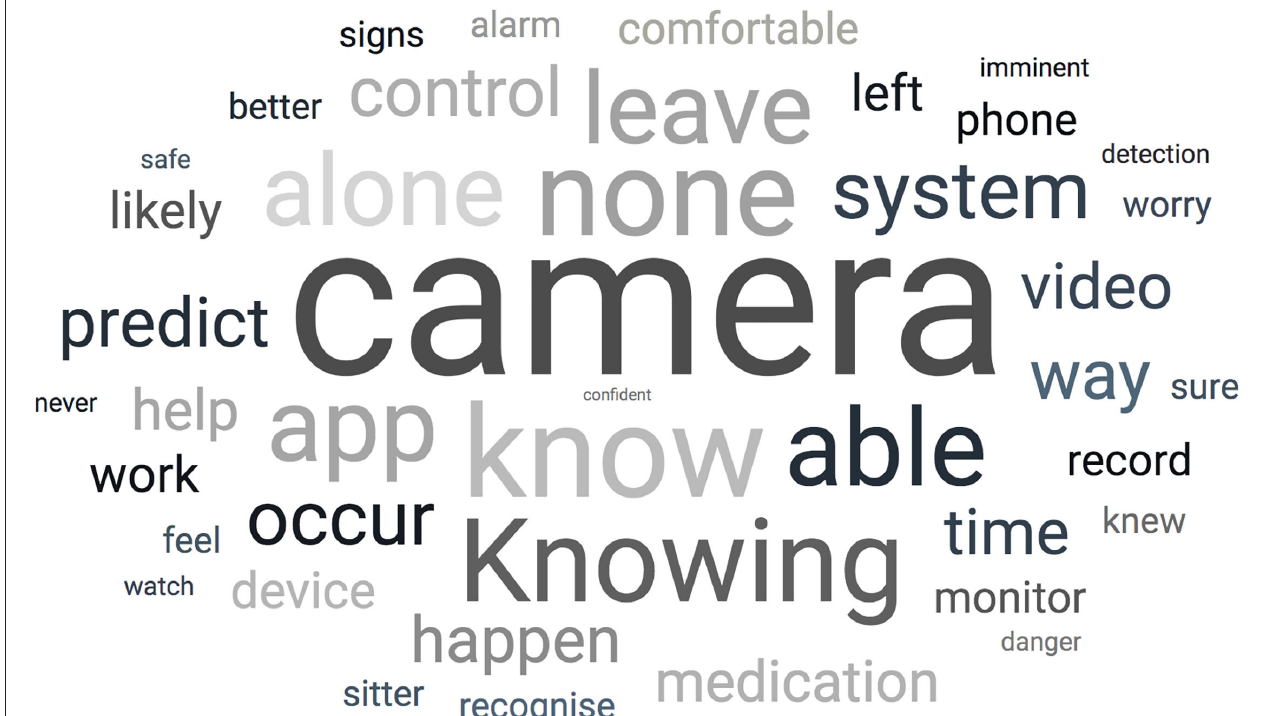
FIGURE 3 | Word cloud—open answers to the question “What factors would make it easier to leave your dog at home alone?”.